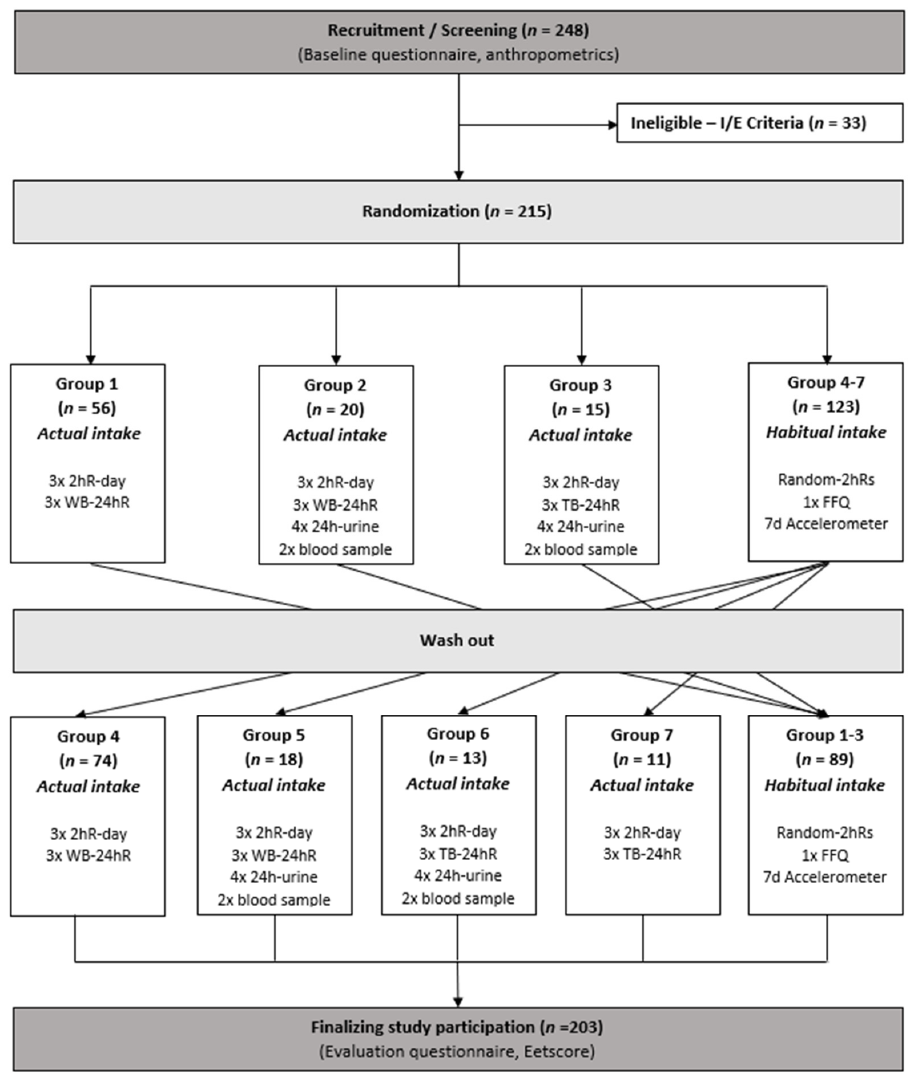
Figure 1. Flowchart study design. 2hR-day: Full day of consecutive 2-h recalls; WB-24hR: web-based 24-h recall; 24-h urine: 24-h urine collection; TB-24hR: telephone-based 24-h recalls; Random-2hRs: Randomly distributed 2-h recalls; FFQ: food frequency questionnaire; Eetscore: Web-based screener for diet quality.